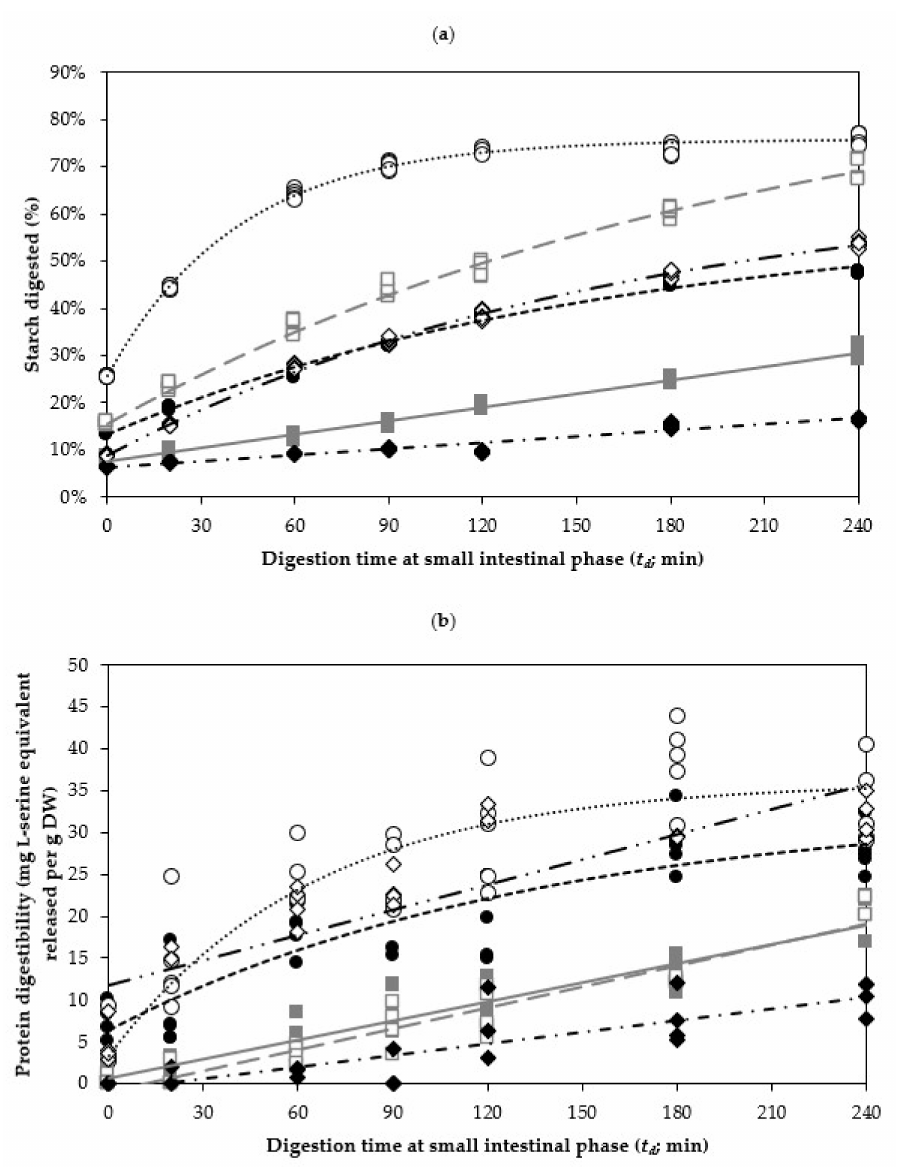
Figure 3. In vitro ( a ) starch and ( b ) protein digestion kinetic of boiled legumes in the small intestinal digestion. Markers indicate experimental values, while predicted values are shown as lines. The lines represent the fitted values by an appropriate kinetic model (Tables 3 and 4). Legend: Cowpeas boiled